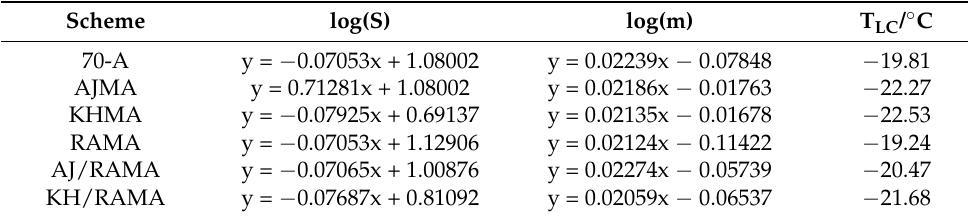
Table 7. Fitting Equation and critical temperature of asphalt.